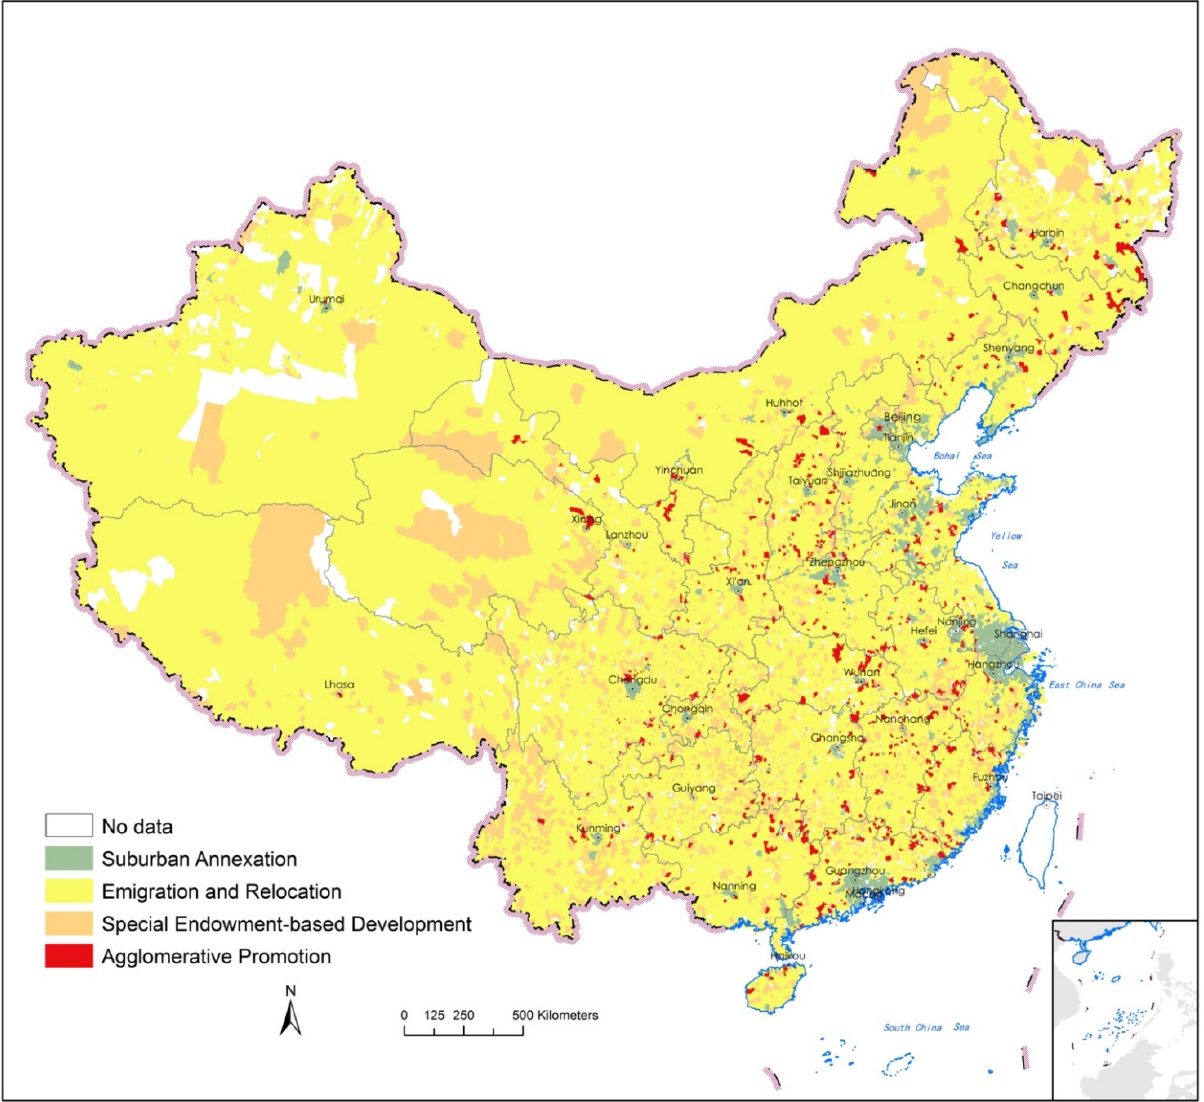
Figure 5. Distribution of the Four Types of Villages. Table 2. Township and Village Counts of the Four Categories.